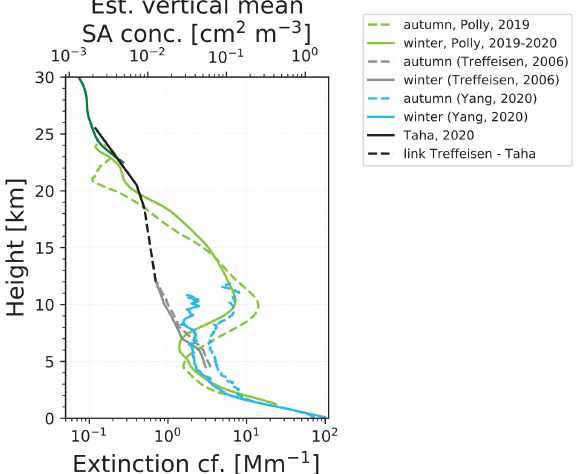
Figure 14. Seasonal mean particle extinction coefficient profiles (532nm; autumn – October and November; winter – December to February), measured with the Polarstern lidar up to 30km height. In addition, extinction profile observations (500–550nm range) found in the literature (see the list to the right of the figure) are given for comparison and to indicate aerosol background conditions during undisturbed times (black and grey profile segments). The dark green extinction curve from 22.5 to 30km (MOSAiC autumn and winter mean value) is computed from the 532nm signal profile by applying the Klett method in order to indicate the background aerosol level above 25km height. The surface area concentration (upper y axis) is related to the MOSAiC smoke extinction profiles. More details are given in the